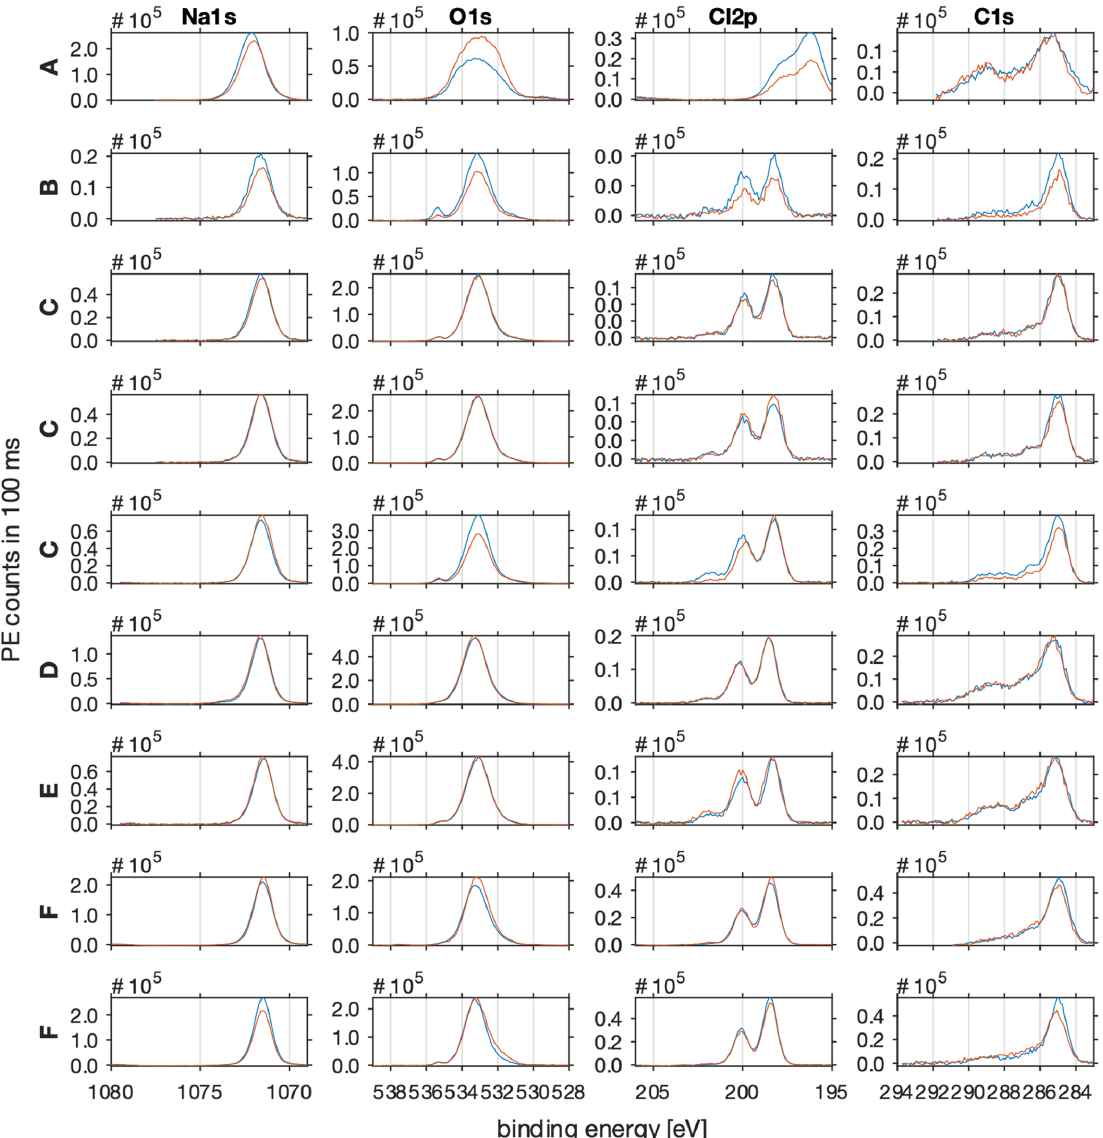
Figure A1. The photo emission intensities as acquired before (blue line) and after (red line) each NEXAFS spectrum. The photo emission (PE) spectra of sodium (Na1s) are shown in column 1, of oxygen (O1s) in column 2, of chlorine (Cl2p) in column 3, and of carbon (C1s) in column 4. All spectra were acquired at the PHOENIX beamline of SLS of the PSI with a photon energy of 2200eV. Pass energy was set to 100eV and dwell time to 100ms. Beamline slits were 2 × 2mm. The C–H feature at 285eV of the C1s photoemission spectra served as the binding-energy reference, and all spectra were shifted by 4–5.5eV to account for charging